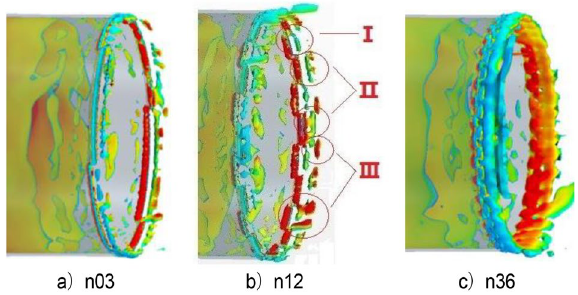
Figure 33. Nozzle vortex structure under typical working conditions (Q = 300 /s 2